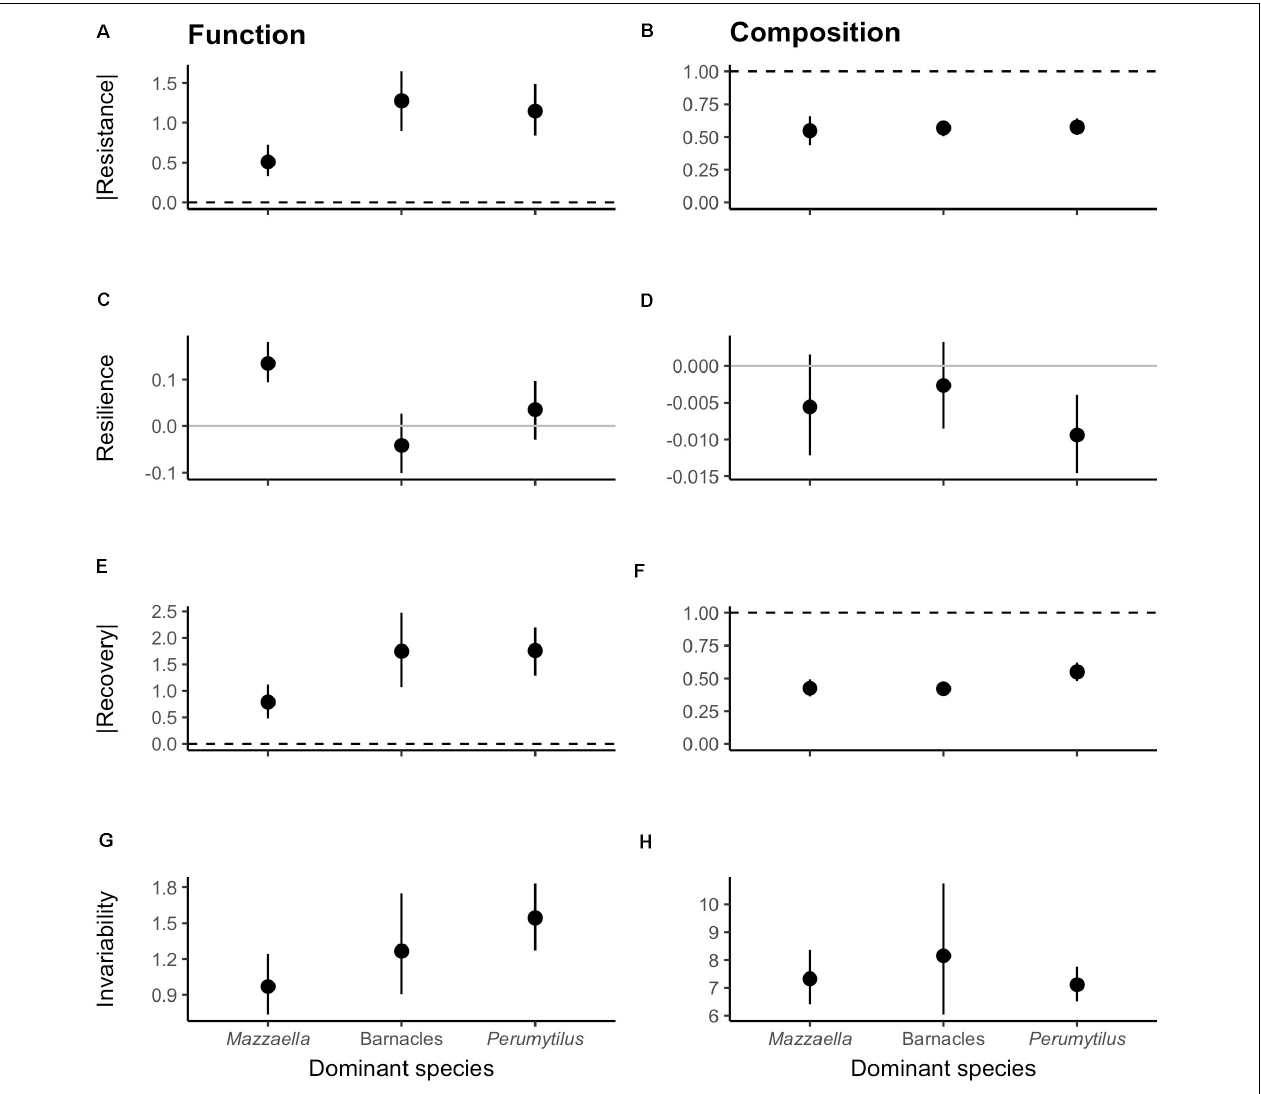
FIGURE 2 | Four dimensions of stability in the (A,C,E,G) functional and (B,D,F,H) compositional domains. Note that (A) functional resistance and (E) recovery are shown as absolute values in order to compare magnitudes, rather than directions of effects. Values are mean ± 95% confidence intervals. Dashed lines represent maximum resistance and recovery; solid gray lines represent minimum resilience. All stability dimensions statistically differed from reference values, excepting (C) functional resilience of barnacle- and Perumytilus- dominated communities ( t -tests: t 16 = − 1.24, P > 0.05; t 28 = 1.28, P > 0.05, respectively). Accordingly, the three types of communities exhibited similar stability responses, excepting functional resilience (GLMM contrasts: Mazzaella > barnacles; Mazzaella > Perumytilus ).